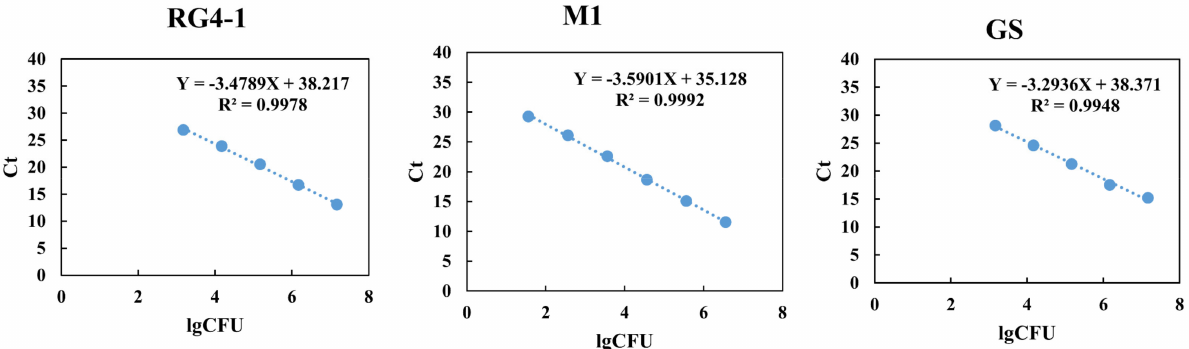
Figure 4. qPCR standard curves for the three B. longum